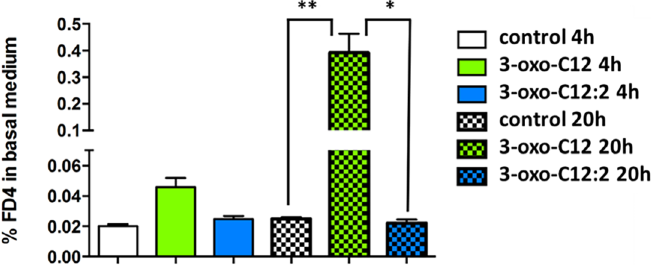
Fig 9. Proportion of FD4-FITC in the basal medium after 4 hours on Caco-2/TC7 cells cultured in transwell. Cells were pre-exposed with AHLs 3-oxo-C12 and 3-oxo-C12:2 at 200 μM for 4 and 20 hours. (cid:3) p < 0.05 (cid:3)(cid:3) p <